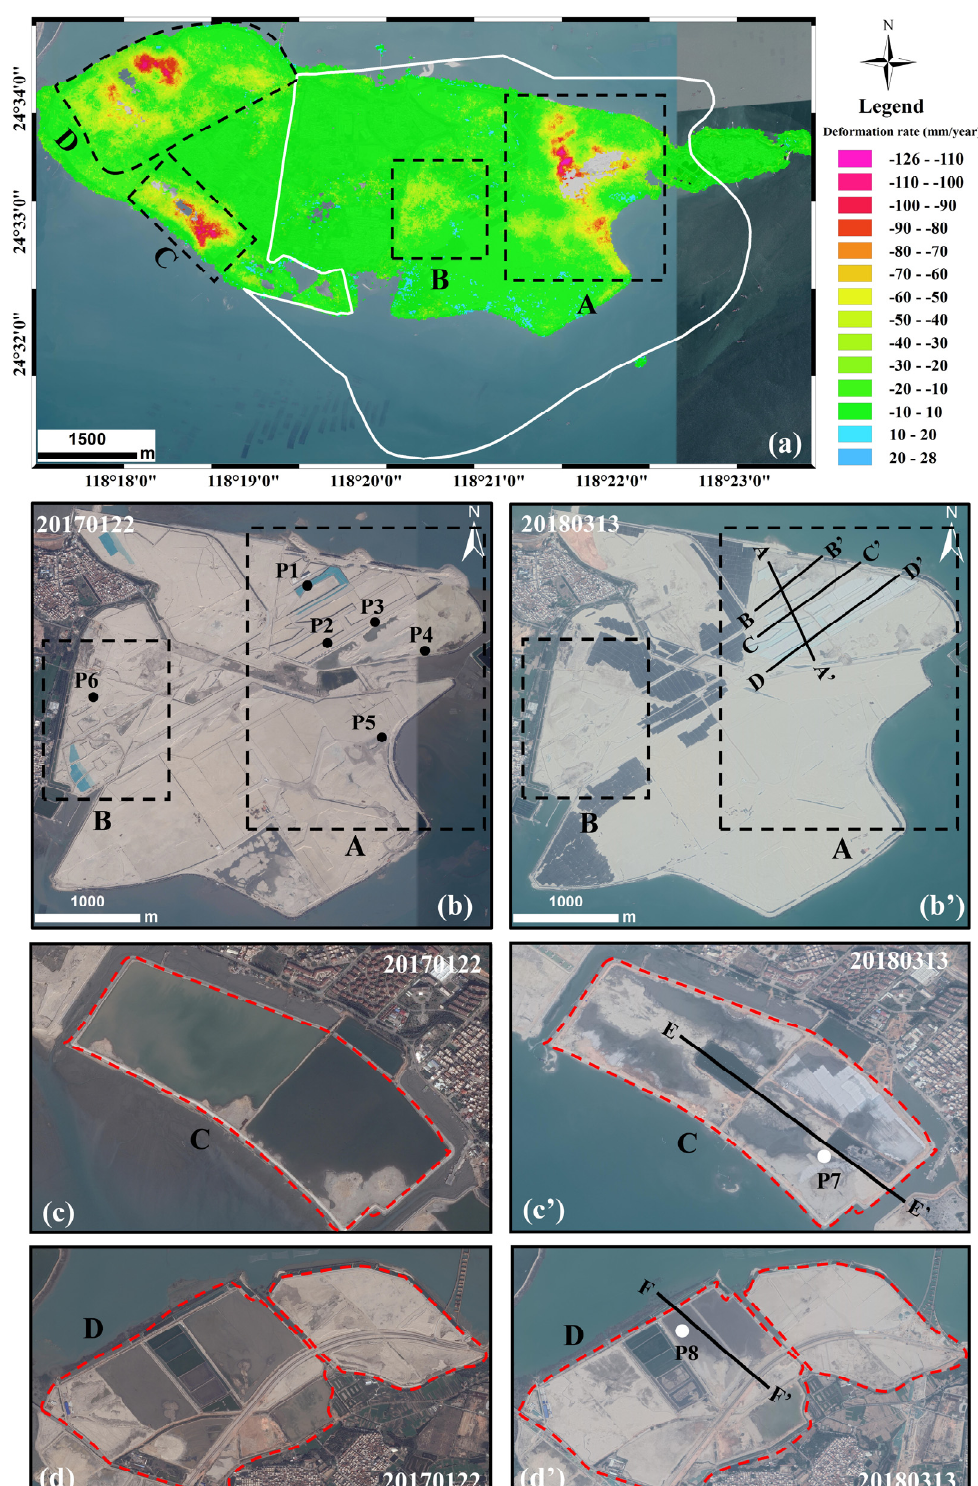
Figure 6. Ground deformation rate map ( a ) and three sections of remote sensing images acquired on 22 January 2017 in regions A, B, C, and D in ( b ), ( c ), and ( d ), respectively, and on 13 March 2018 in ( b’ ), ( c’ ), and ( d’ ), respectively. Solid black lines from AA’ to FF’ denote profile locations, which are further shown in Figure 7. Points P1 to P8 (marked with black and white dots) are chosen to show the time series deformation in Figure 8.